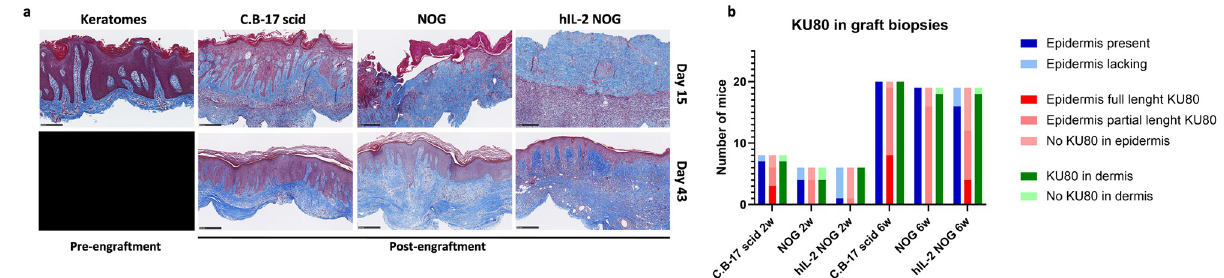
Fig 3. Presence and appearance of epidermis over time in the different mouse strains. (a) Masson’s Trichrome (MT) stain of keratomes pre- engraftment (six donors, three biopsies from each keratome, n = 18) and graft biopsies from C.B-17 scid, NOG and hIL-2 NOG mice on day 15 (C.B-17 scid n = 8; NOG n = 7; hIL2-NOG n = 6) and 43 (C.B-17 scid n = 20; NOG n = 20; hIL2-NOG n = 11). Representative slides are shown. The bar equals to 250 μ m and slides are shown in 10X magnification. (b) The presence of epidermis and KU80 positive stainings in grafts were evaluated. The presence of epidermis was evaluated from MT stainings as either lacking or present (full or partial). Immunohistochemical stainings of the grafts with anti- human KU80 on day 15 and 43 were used to evaluate how much of the epidermis was human (either full length of the biopsy, partial length of the biopsy or no KU80 positive staining in epidermis) and the presence of human cells in dermis (KU80 positive cells present or not